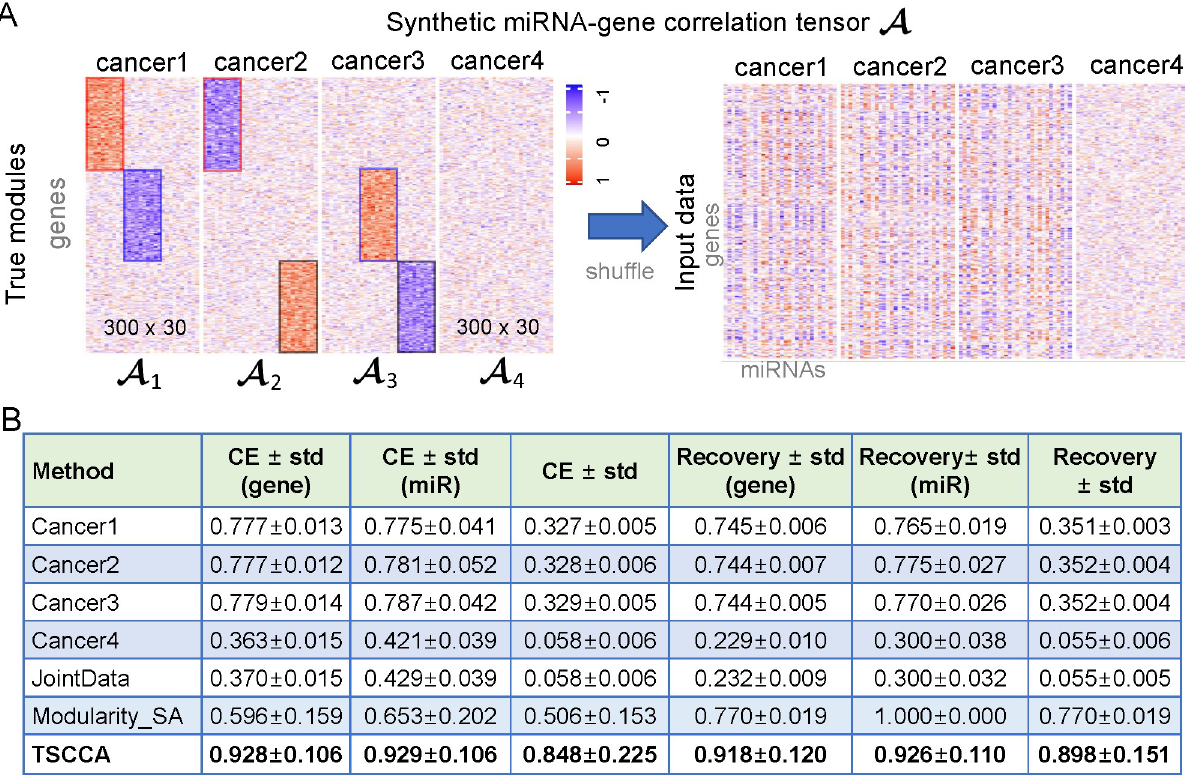
Fig 8. Comparison of results from different algorithms on the simulated data and TCGA data. (A) A synthetic miRNA-gene correlation tensor A , which contains four matrices with the same number of genes (rows) and miRNAs (columns), and includes three true modules framed by rectangular boxes of different colors. The shuffled A is as the input of tested methods by shuffling the genes (rows) and miRNAs (columns) of A . (B) Comparison of different methods in terms of CE ± std and Recovery ± std on the simulated data. The Recovery and CE scores are computed based on A s generated